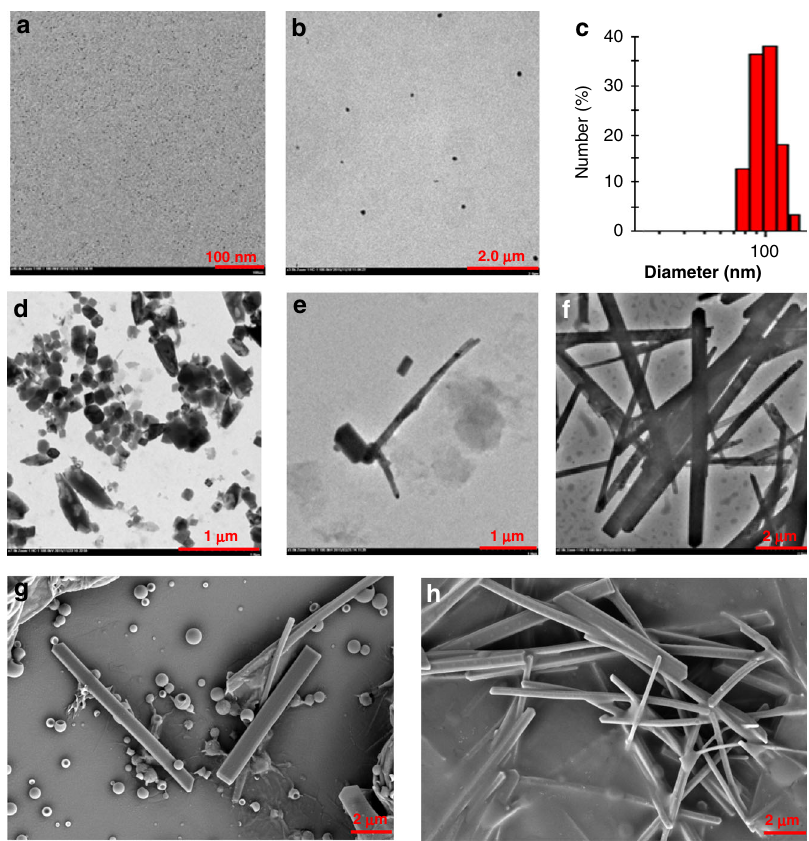
Fig. 3 Electron microscope images of self-assemblies formed from 5 or 5 2 (cid:129) 7 , and DLS data of 5 . a TEM image of 5 (1.00 × 10 − 4 M). b TEM image of 5 (1.00 × 10 − 4 M) with the addition of 4 equiv n -Bu 4 NCl in THF. c DLS data of 5 (1.00 × 10 − 4 M) with the addition of 4 equiv n -Bu 4 NCl in THF. d TEM image of 5 (1.00× 10 − 4 M) with the addition of 4 equiv n -Bu 4 NCl in aqueous solution. e TEM image of 5 2 (cid:129) 7 (1.00× 10 − 4 M) in aqueous solution. f TEM image of 5 2 (cid:129) 7 (1.00 × 10 − 3 M) with the addition of 4 equiv n -Bu 4 NCl in aqueous solution. g SEM image of 5 2 (cid:129) 7 (1.00 × 10 − 3 M) in aqueous solution. h SEM image of 5 2 (cid:129) 7 with the addition of 4 equiv n -Bu 4 NCl (1.00 × 10 − 3 M) in aqueous